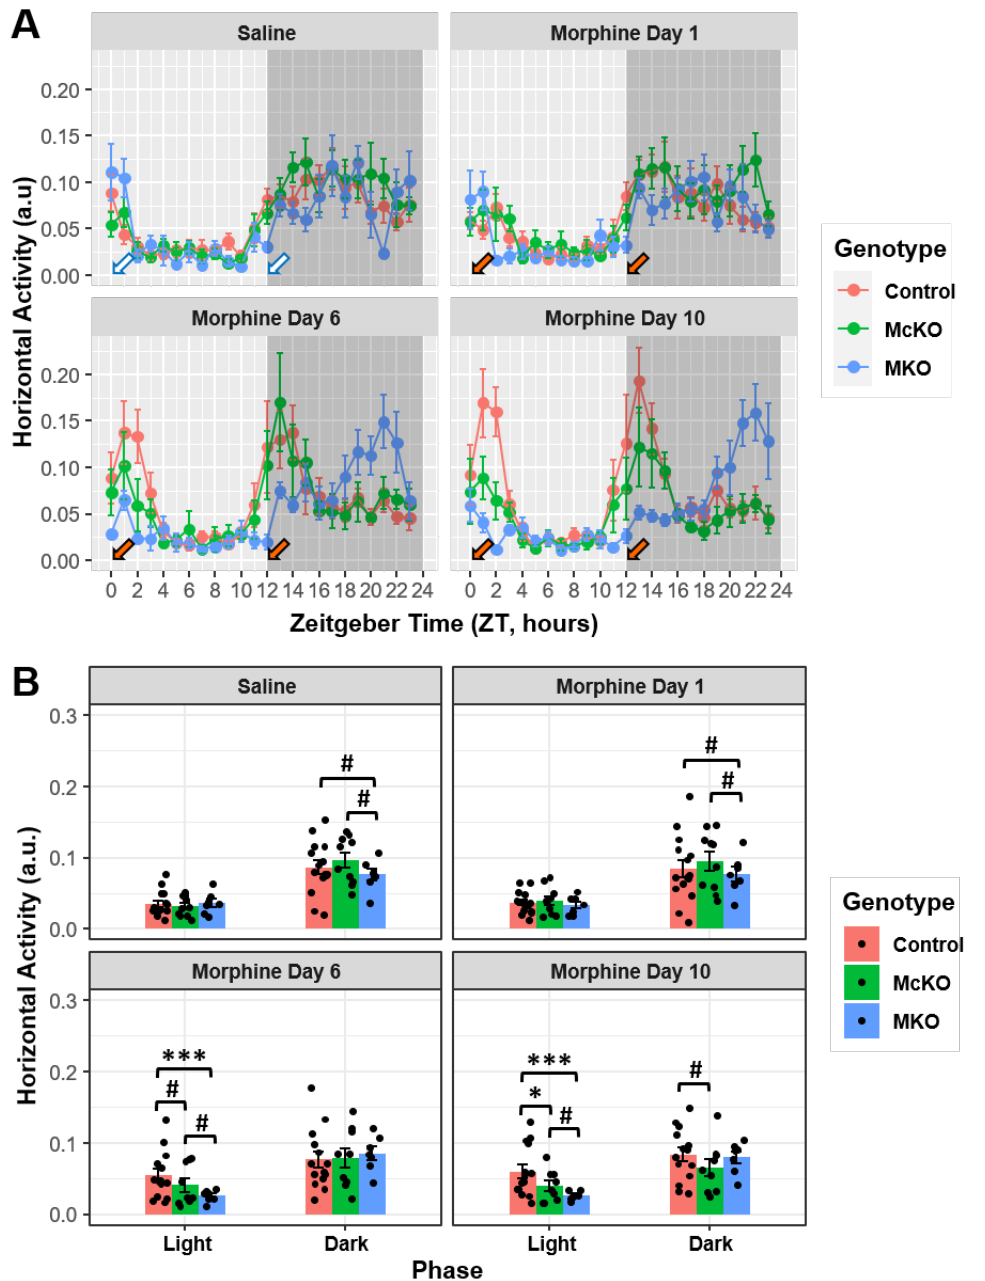
Figure 1. Prolonged but not acute morphine exposure differentially altered locomotor activity in Control, McKO, and MKO mice across light and dark phases. ( A ) Average behavioral activity plotted for Control ( n = 14–15), McKO ( n = 9–10), and MKO ( n = 7) by hour (Zeitgeber Time) for different experimental days. Arrows indicate time of i.p. injection with either saline (white arrows) or 20 mg/kg of morphine (orange arrows). ( B ) Control and McKO animals exhibited increased horizontal activity compared with MKO animals. After prolonged morphine exposure, control mice exhibited increased locomotor activity compared with McKO littermates. Analysis performed using a three-way ANOVA (phase x genotype x experimental day) with a Holm – Bonferroni post hoc adjustment performed on all pairwise comparisons. (# p < 0.05, * p < 0.01, *** p <0.0001). Data presented as mean ± SEM.